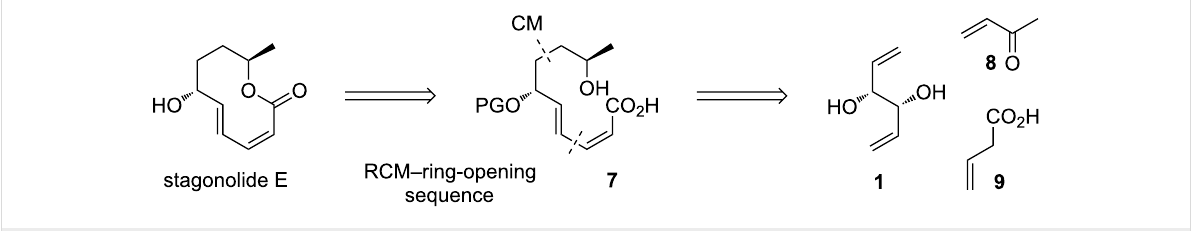
Scheme 2: Synthetic plan for stagonolide E.